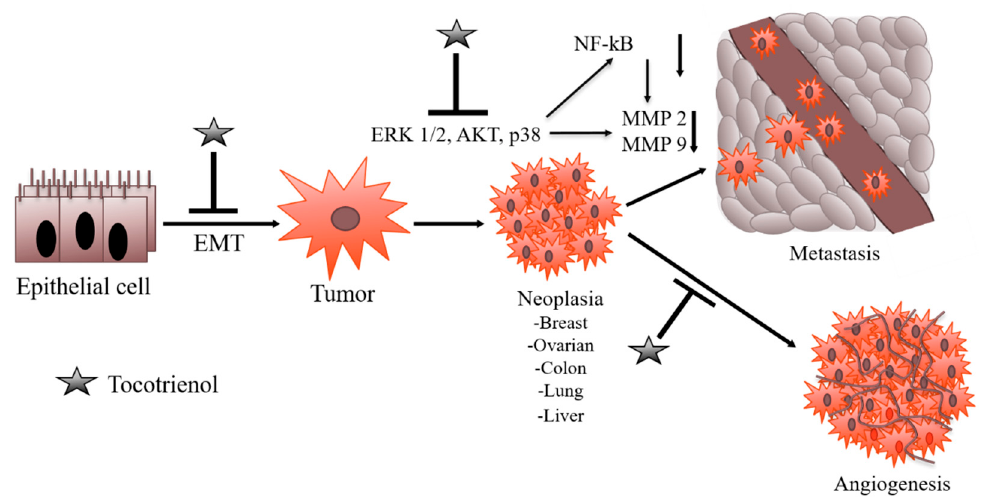
Figure 4. Tocotrienols also mitigate tumor metastasis and angiogenesis by regulating the MAPK (mitogen-activated protein kinases), Akt signaling pathways and subsequently MMPs (matrix metalloproteinase), snail, twist, β -catenin, and uPA gene expression. Tocotrienols also reduce the activity/expression of HIF-1 α (hypoxia-inducible factor 1-alpha) and VEGF/VEGFR (Vascular Endothelial Growth Factor and Its Receptor) molecules.